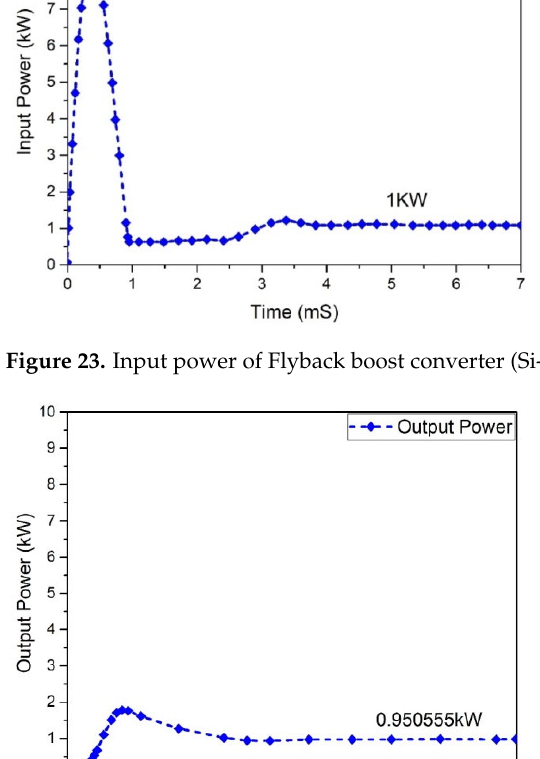
Figure 23. Input power of Flyback boost converter (Si ‐ MOSFET).